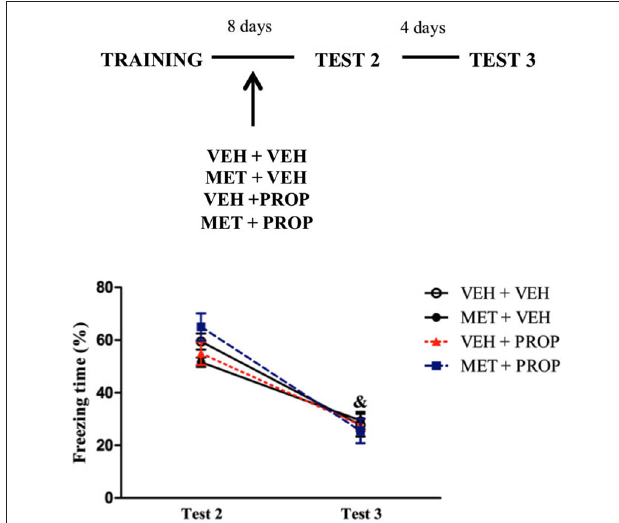
FIGURE 6 | Acute metyrapone and propranolol treatments without first context exposure did not modify fear memory . There were no differences between the groups when the treatments were administered without Test 1 re-exposure. VEH + VEH = vehicle group ( n = 9); MET + VEH = metyrapone group ( n = 8); VEH + PROP = propranolol group ( n = 9); MET + PROP = metyrapone and propranolol group ( n = 8). & P < 0.05, compared to Test 2, for all groups.